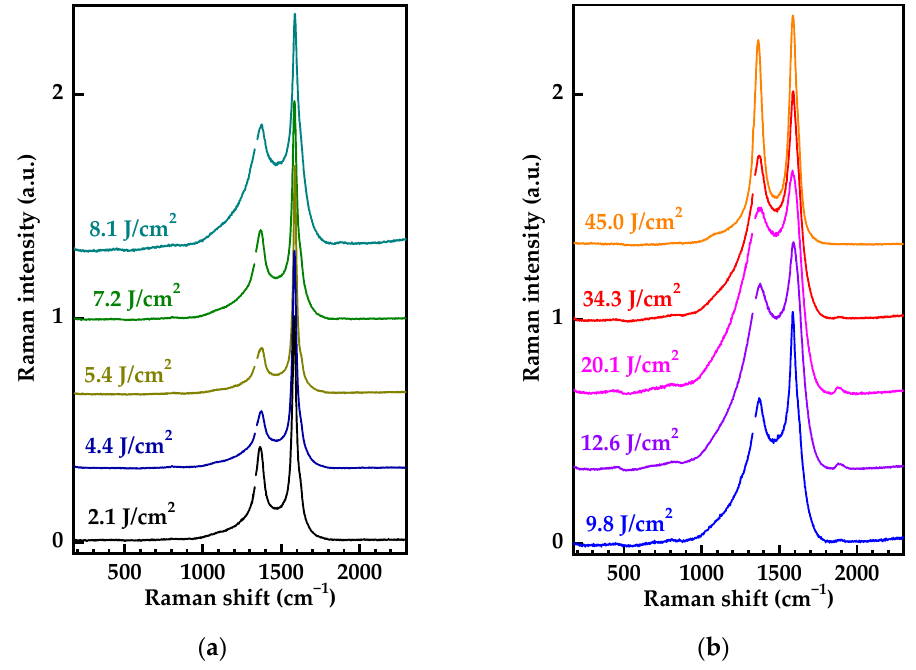
Figure 6. ( a ) Raman spectra of graphitized structures obtained at a different laser fluences. ( b ) The Figure 6. Raman spectra of graphitized structures obtained at lower ( a ) and higher ( b ) laser fluences. spectra are normalized to the amplitude of G-band and shifted for clarity. All the spectra are normalized to the amplitude of G-band and shifted for